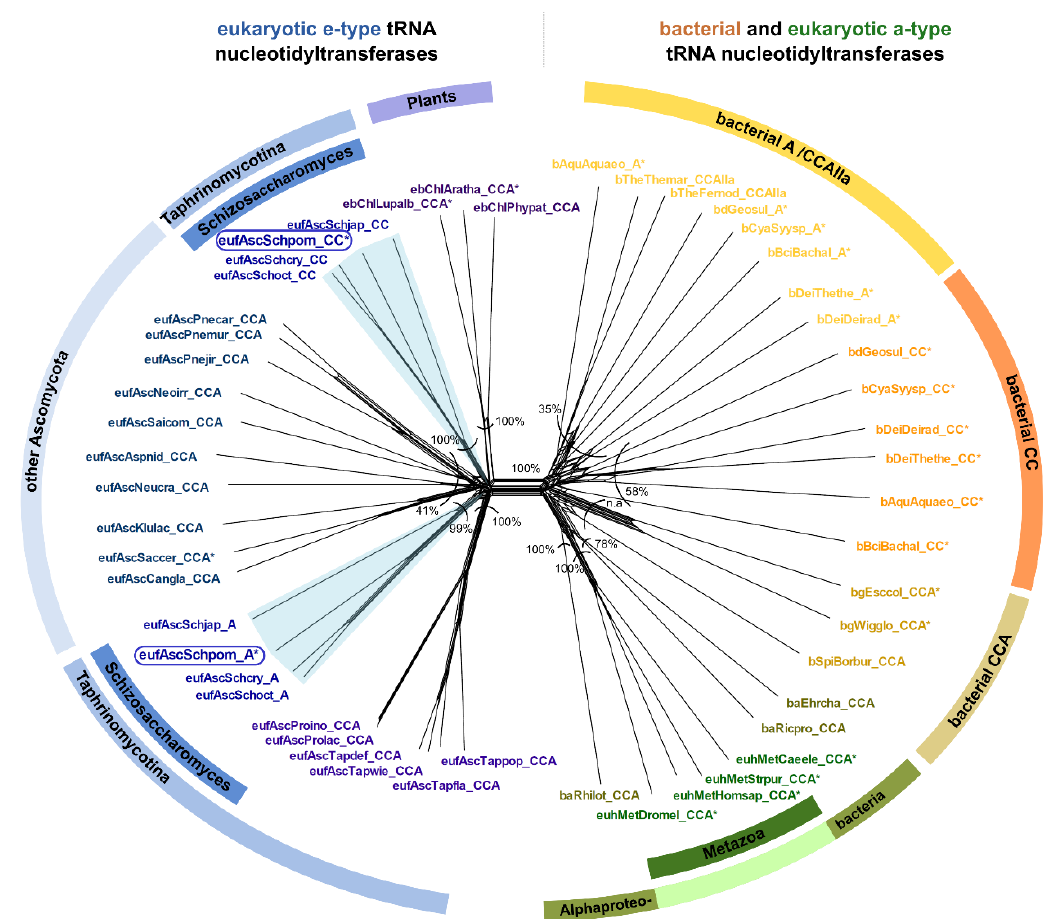
Figure 3. Phylogenetic network of tRNA nucleotidyltransferase sequences from Taphrinomycotina in a greater context. The split in the center separates e-type (left) and a-type (right) sequences. The left side includes all sequences from genome-sequenced Taphrinomycotina. Schizosaccharomyces species are represented by both confirmed and putative CC-adding and A-adding enzyme sequences. Each of the corresponding subtrees of these Schizosaccharomyces enzymes resembles the species phylogeny in topology and branch length, indicating that both enzymes evolved at the same rate. These data exclude a horizontal gene transfer event and indicate subfunctionalization shortly after gene duplication. The cluster on the right side includes CCA-, CC-, and A-adding enzyme sequences of bacterial origin (including metazoan a-type sequences of alphaproteobacterial origin). An asterisk (*) marks sequences that have been experimentally verified for their function. The frames indicate the investigated S.